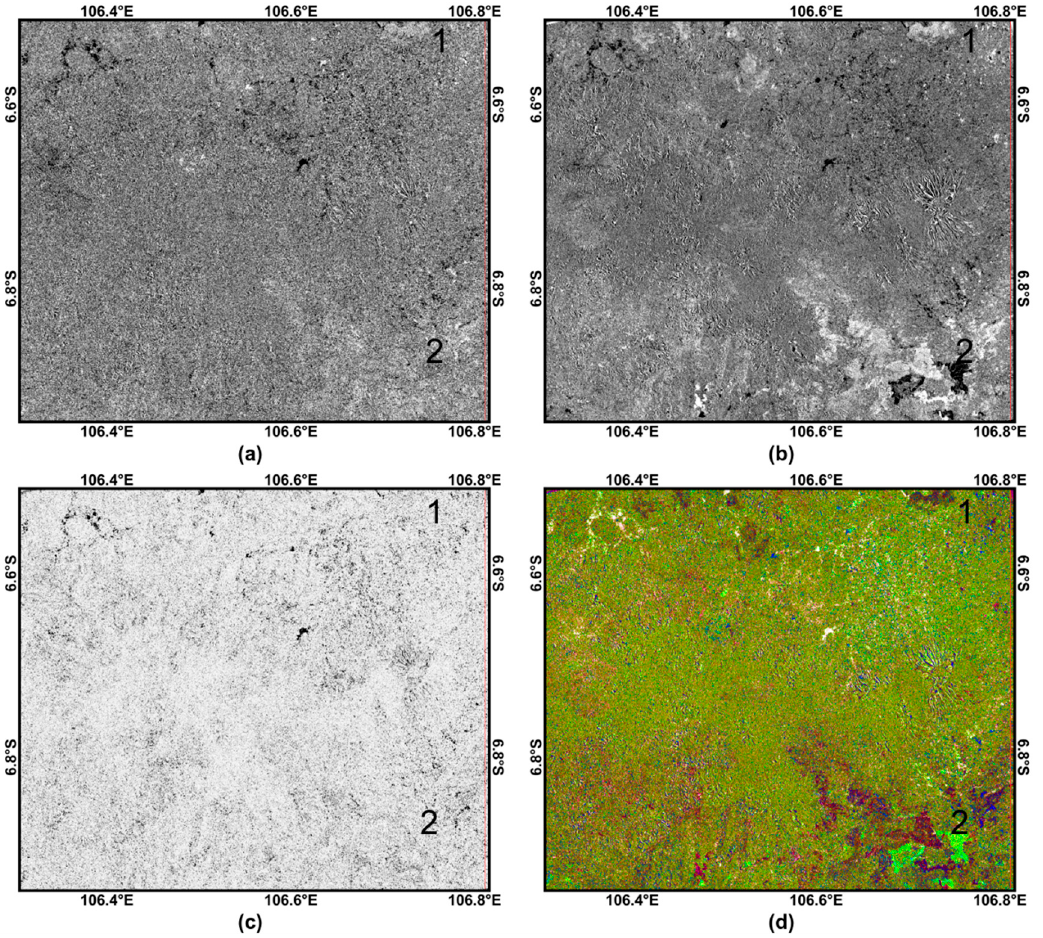
Figure 4. The result of IRMAD processing, i.e., ( a ) MAD variate-1, ( b ) MAD variate-2, ( c ) Chi-square layer, and ( d ) RGB of those three layers. Letters 1 and 2 were located at areas with different visual change indication.